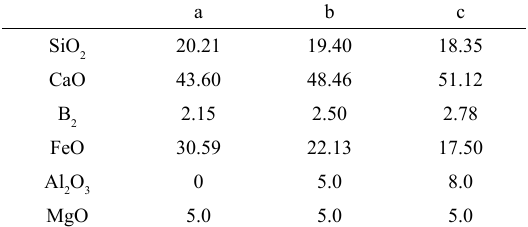
Figure 7. Isothermal Saturation Diagram B